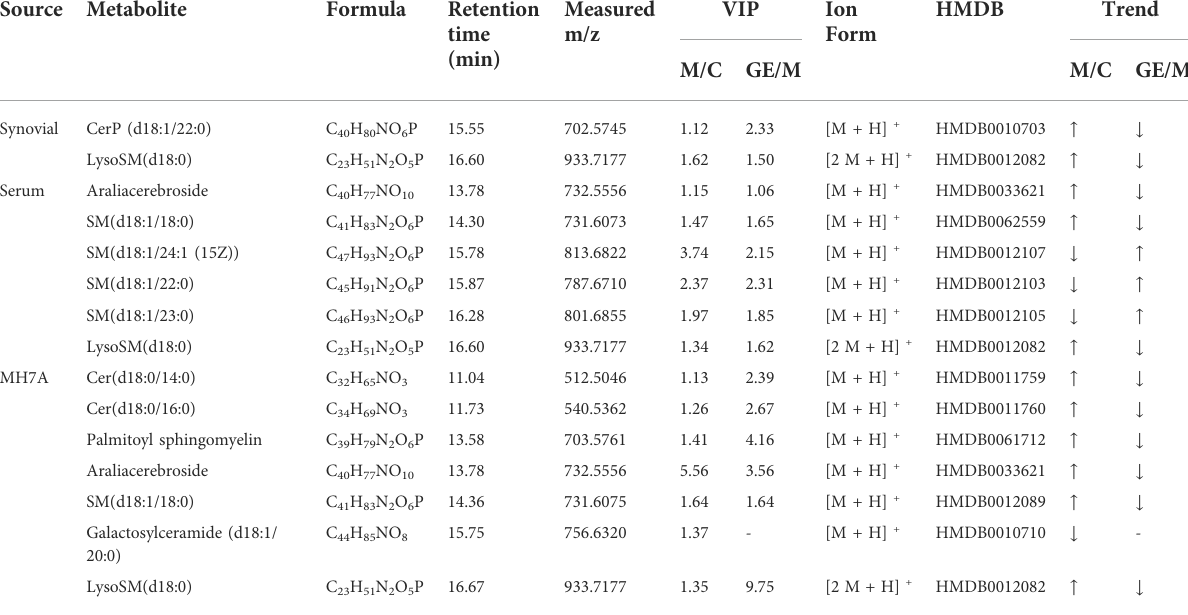
TABLE 1 | Differential sphingolipid metabolites identi fi ed in synovial, serum and MH7A cells and GE intervention. Source Metabolite Formula Retention